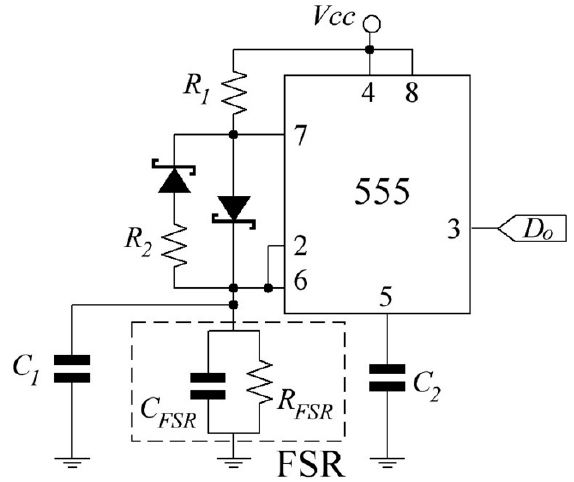
Figure 3. The authors proposed a circuit for self-compensated measurements in FSRs. The equivalent model for the FSR is enclosed within the dashed lines.